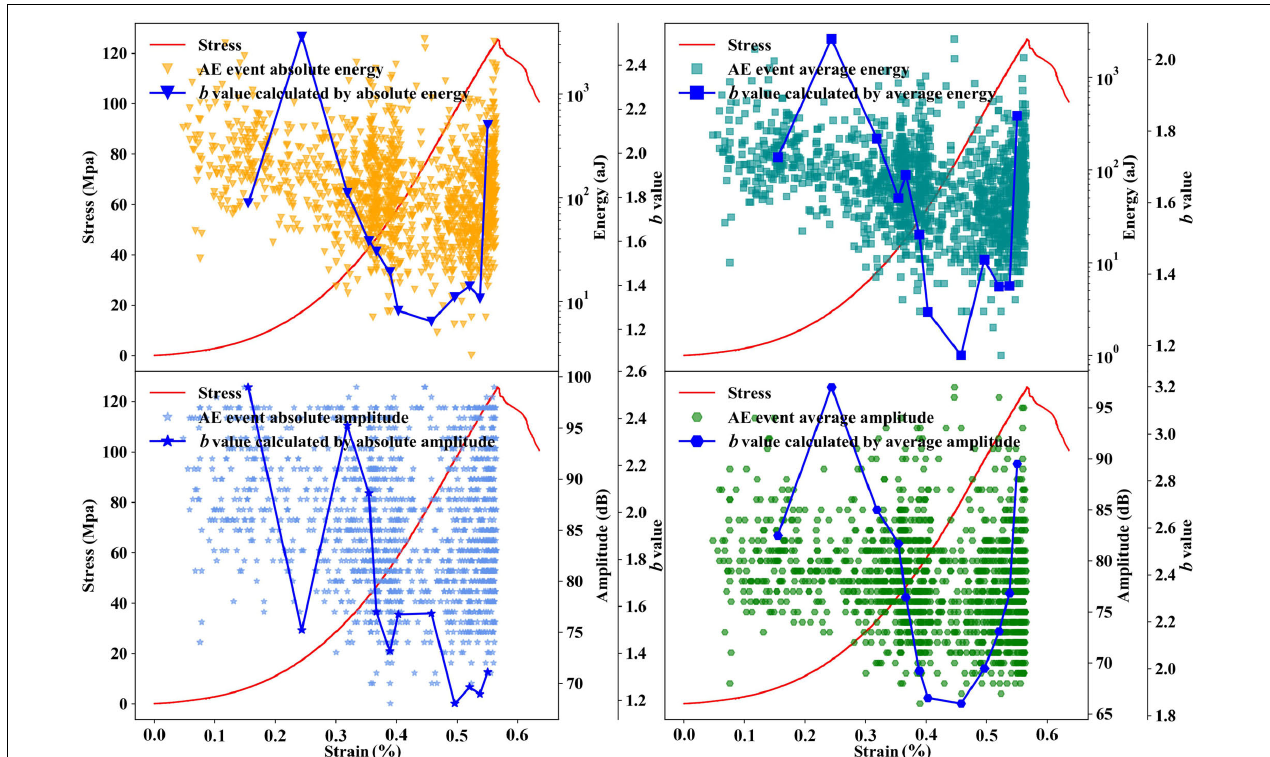
FIGURE 3 | The variation in 4 AE b values (blue point-line) of dry granite versus strain under uniaxial compression. The distribution characteristics of the absolute amplitude (blue point), absolute energy (orange point), average amplitude (cyan point), and average energy (green point) of the AE event show good consistency with the fluctuation of the b